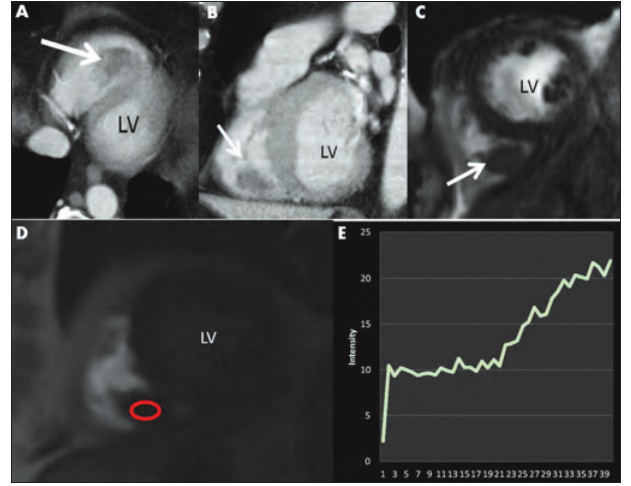
Fig. 5. Post contrast venous phase chest CT scan in a 65-year-old man with gastric carcinoma. (a) Transaxial images demonstrate a filling defect (arrow) in the basal right ventricle (LV = left ventricle). (b) Post contrast-enhanced sagittal reconstructed image of the chest demonstrates a filling defect in the basal right ventricle (LV = left ventricle). (c) Cardiac MRI steady-state free precession image obtained in a short axis orientation demonstrates a mass lesion in the basal right ventricle (arrow) (LV = left ventricle). (d) The right ventricular mass demonstrates gadolinium enhancment during perfusion imaging as demonstrated on (e) the enhancement curve display on the